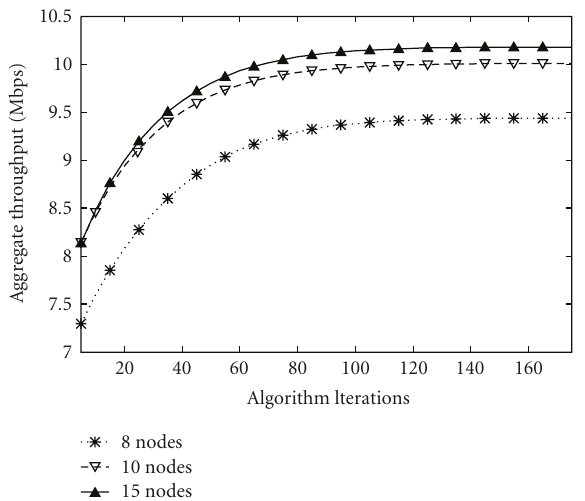
Figure 5: Network achievable throughput. The achievable through- put for our joint power control, base station assignment, and channel assignment scheme is compared with the throughput of Li et al. and a single MBS WiMAX network as the number of nodes is varied.